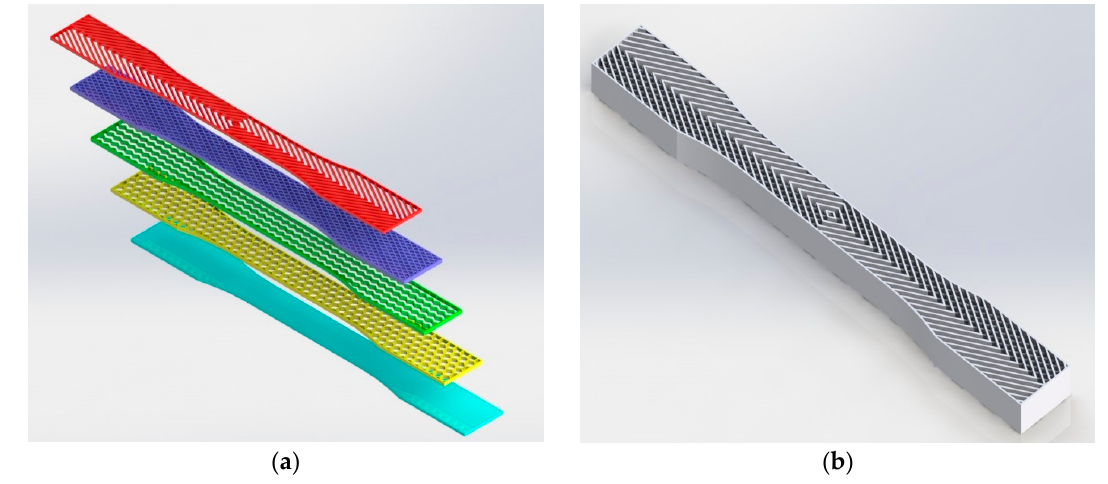
Figure 5. ( a ) Classified layers and ( b ) CAD model according to ISO/ASTM.